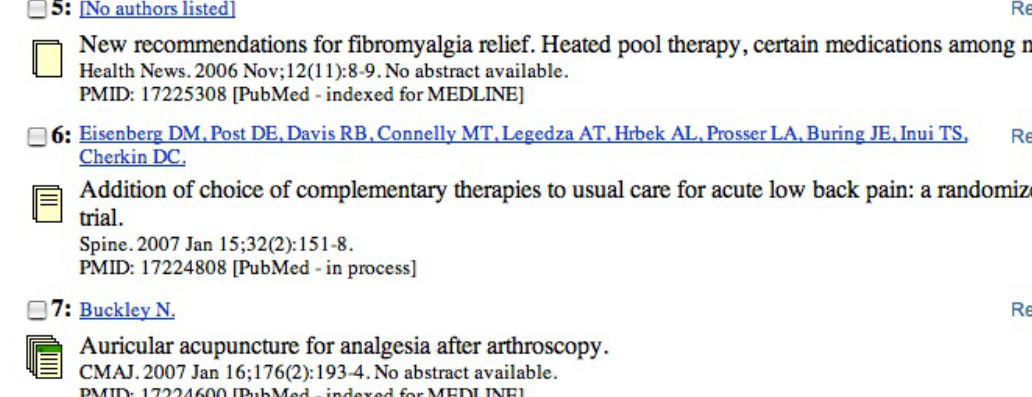
Figure 2. Partial results of a PubMed search on “complementary medicine,” showing icons (from top to bottom) for “no abstract,” “abstract only,” and “open access to full-text article” (although no abstract is available) and hyperlinks to “Related Articles” and “Links” (to the full text on publisher and/or library